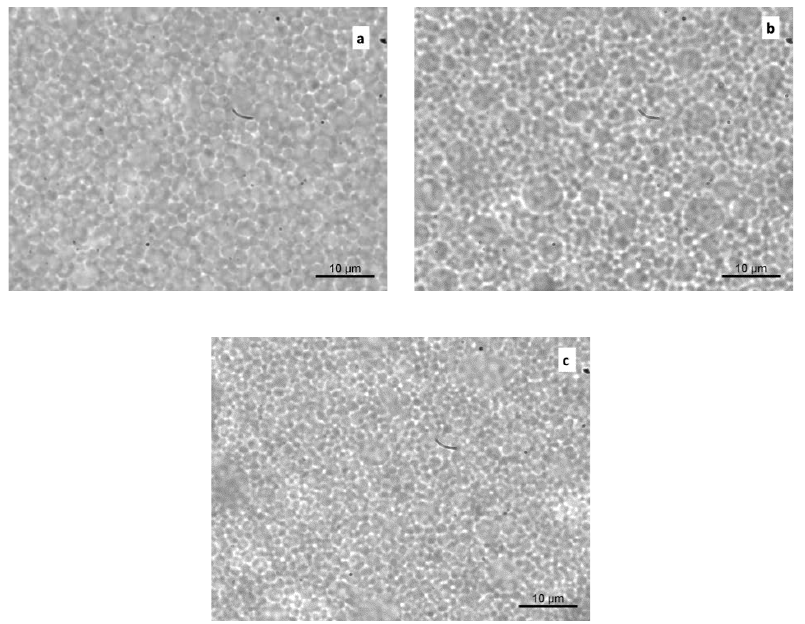
Figure 2. Optical micrograph images of mayonnaise samples just after preparation. Control ( a ), Mayo + OLE ( b ), and Mayo + Alg/Pec ( c ).